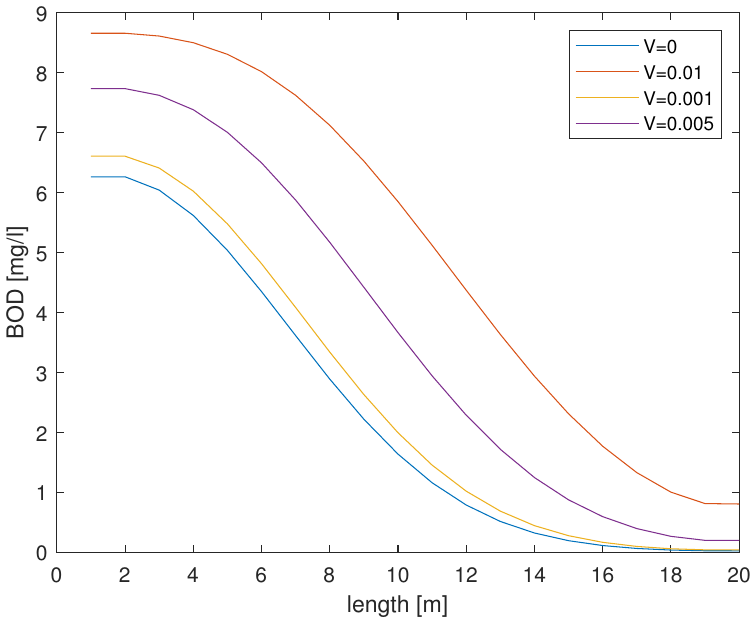
Figure 14. BOD distribution, including diffusion ( D > 0 ) , at different velocities in the same time moments.